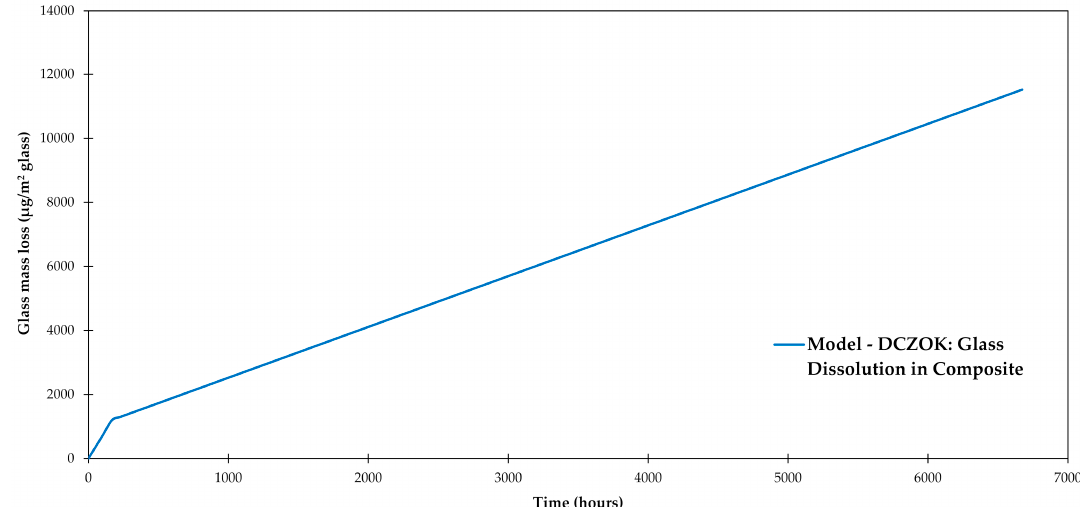
Figure 6. Glass-fiber dissolution modeled using dissolving cylinder zero-order kinetics (DCZOK) for the studied composite, after [28,47,63].